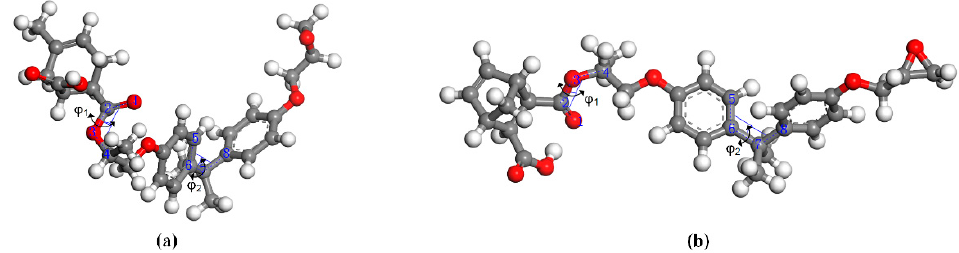
Figure 6. The torsional rotation of the specific bond. ( a ) DGEBA-MTHPA; ( b ) DGEBA-NA.